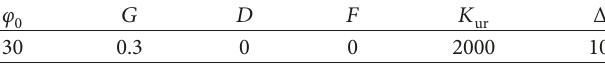
Table 2: Reference values of parameters in the E- ν model.